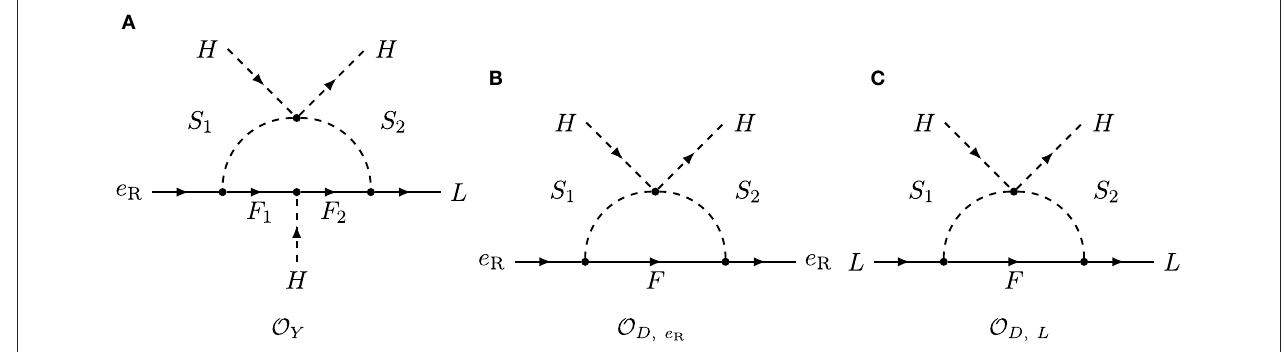
FIGURE 16 | Different 1-loop UV completions of the Yukawa operator O Y given in Equation (68), and the derivative operators O D , e in Equation (70). F and F 1,2 are fermion fields and S 1,2 scalar fields. The Zee-Babu and the scotogenic models are examples of radiative models with HLFV generated at 1-loop order. Figure reproduced from Herrero-García et al. [491].